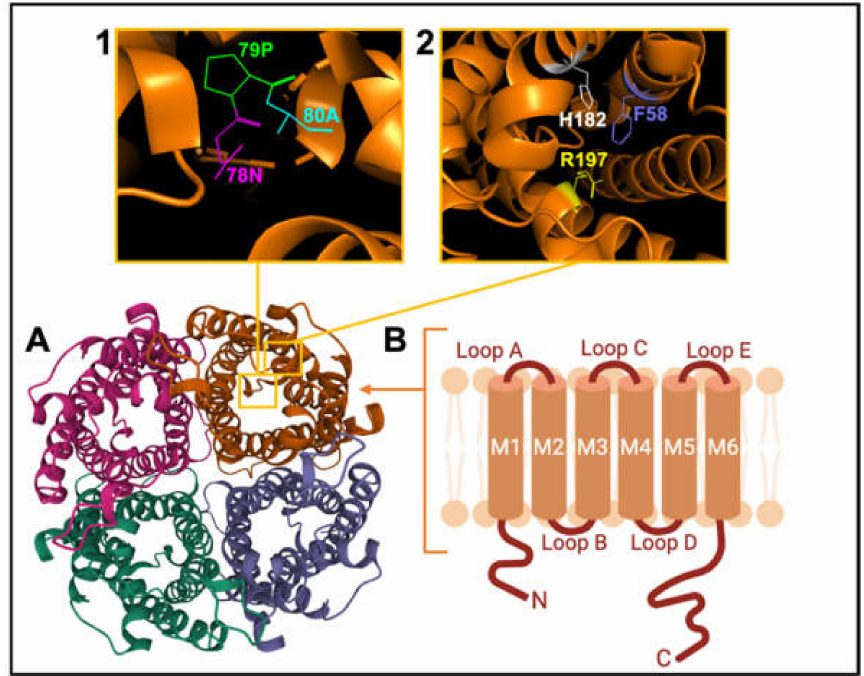
Figure 3. Schematic representation of the AQP channel structure. ( A ). View of the extracellular face of tetrameric AQP1, based on X-ray crystal structure for bovine AQP1 (Protein Data Bank 1J4N). ( B ). Membrane topography of an individual subunit with 6 helical transmembrane domains (M1-M6) connected by loops A to E. ( Inset 1 ) View of Pro 79, Asp 80 and Asn 78 residues of the signature NPA motif. ( Inset 2 ) View of His 182, Phe 58 and Arg 197 residues of the ar/R constriction selectivity